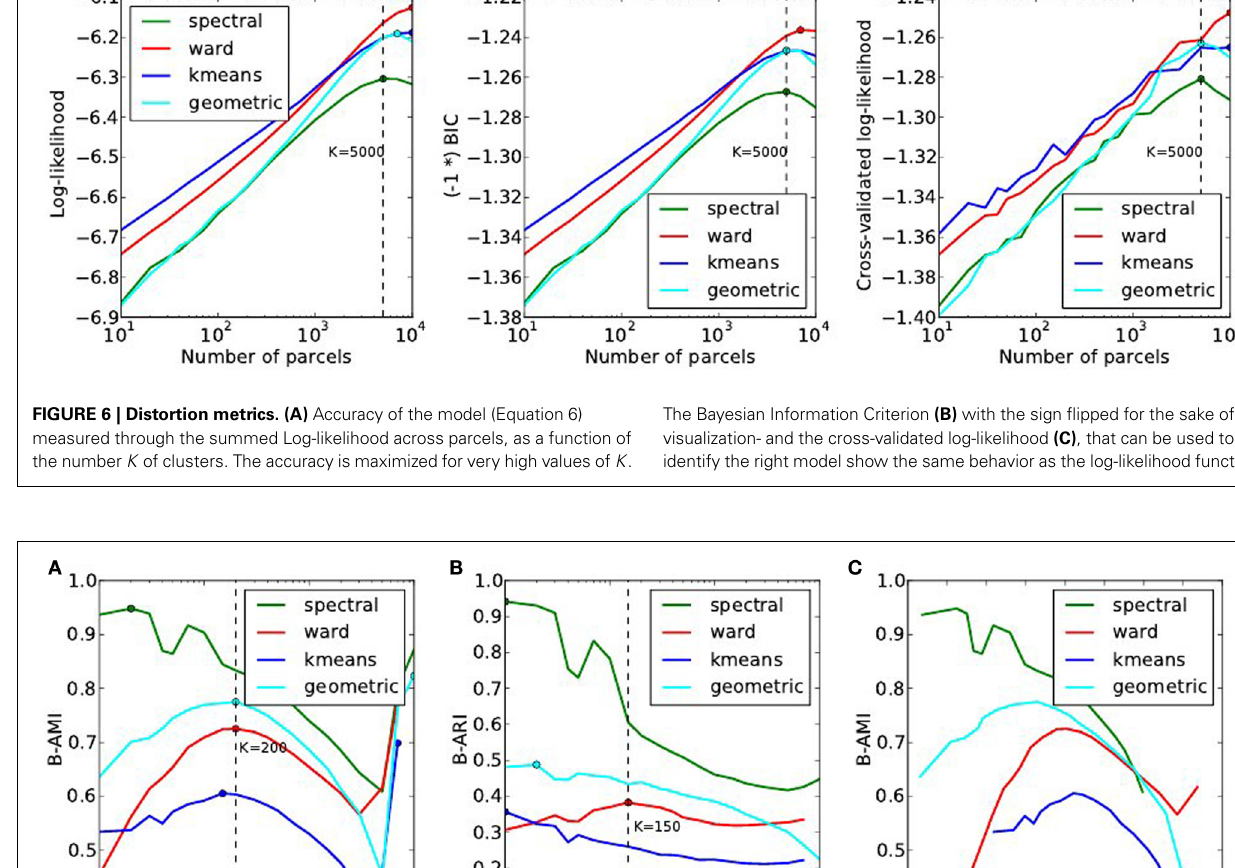
FIGURE 7 | Analysis of the reproducibility index with respect to the number of parcels (A,B) and with respect to the negative log-likelihood (C). For all methods but one, the B-AMI (Bootstrapped Adjusted Mutual information) index (A) shows a (local) maximum for about 200 parcels and decreases against for larger numbers, until it increases again for very large number clusters ( K ≥ 5000). By contrast, B-ARI (Bootstrapped Adjusted Rand Index) (B) only displays the local